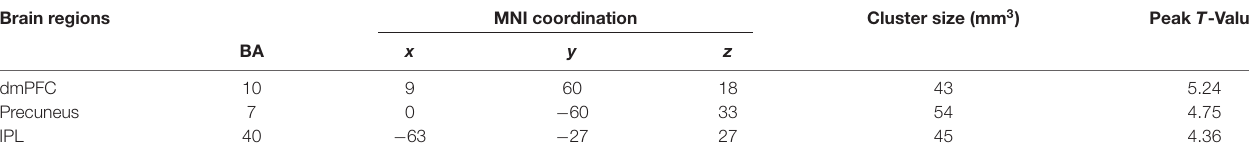
TABLE 1 | Brain regions with significant association between regional ALFF and TTF scores.